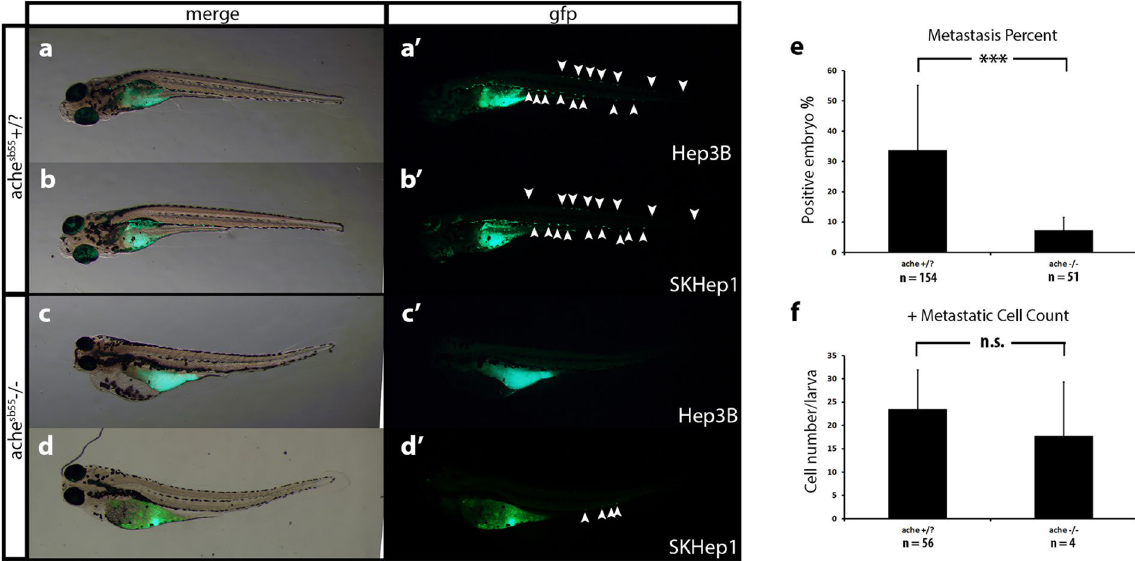
Figure 5. Comparison of metastasis in ache wild-type and mutant larvae. Representative metastatic larva images from Hep3B ( a ) and SKHep1 ( b ) injections into ache + /? (n = 154) larvae are shown. Green fluorescent dye DiO labeled migrated cells can be seen both in Hep3B (a’) and SKHep1 (b’) cell injections. Injection of Hep3B ( c ) and SKHep1 ( d ) into yolk sac of ache − / − (n = 51) larvae did not show a metastatic phenotype (c’,d’) (when there were more than 5 cells in tail region that embryo was counted as positive for metastasis, see (d’) which was counted as negative for metastasis). ( e ) Positive metastasis percent in ache wild-type and mutant groups were compared where there were significantly more metastatic larvae in ache wild-type group ( P = 0.0002, chi-square test). ( f ) To see the effect of metastasis on local tumor size, tumor sizes of metastasis positive and negative groups were compared. Metastasis negative larvae (n = 129) showed a trend for larger tumors although non-significant ( P = 0.1112, T-test) when compared to metastasis positive larvae (n = 60). n.s = not significant.